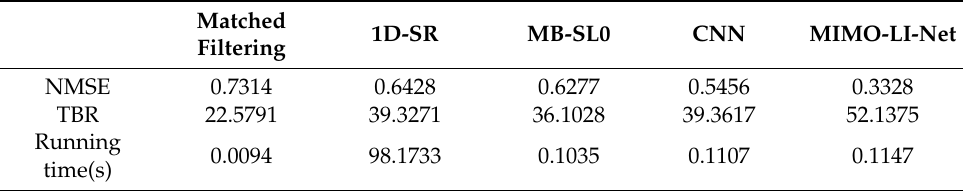
Table 2. Performance comparison of different methods.